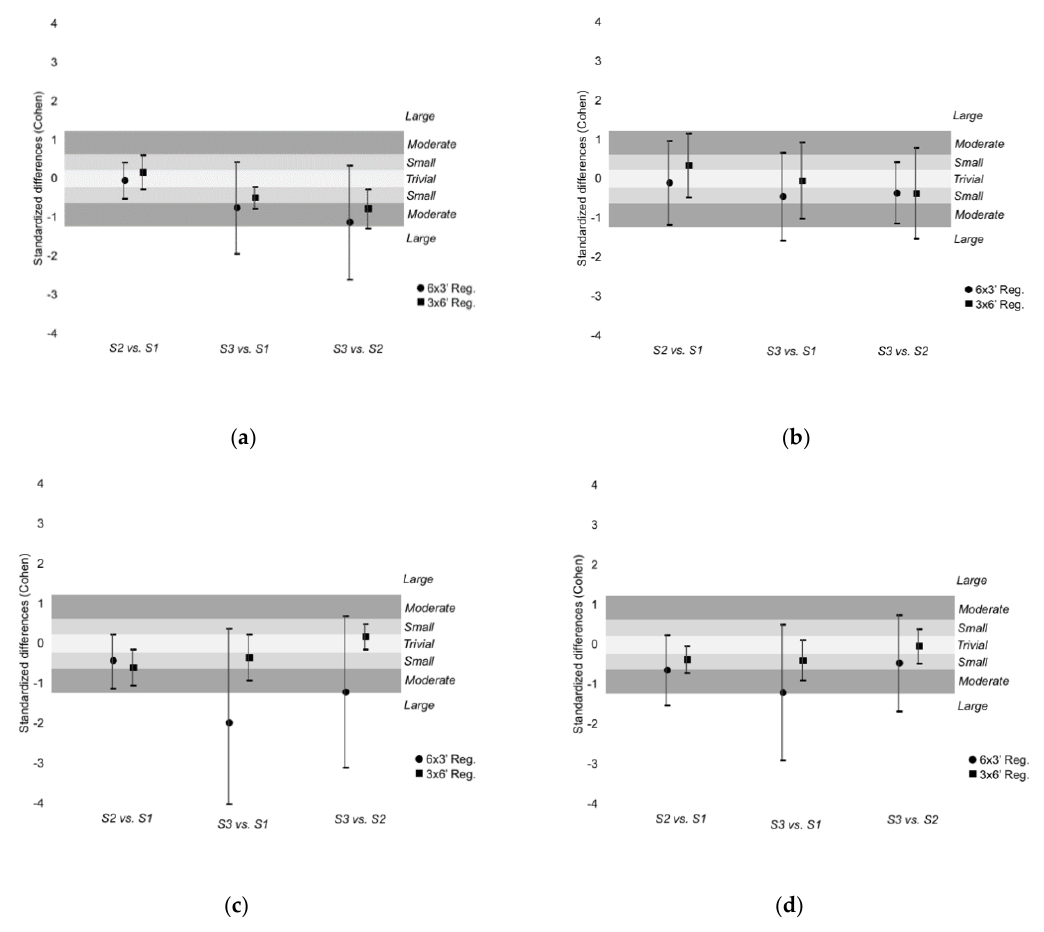
Figure 2. Standardized difference (Cohen) between sets in ( a ) running distance; ( b ) sprinting distance; ( c ) total accelerations; and ( d ) total decelerations. The six sets of the 6 × 3’ regimen were grouped in three sets (S1: mean of set 1 and 2; S2: mean of set 3 and 4; S3: mean of set 5 and 6) to a better visualization and analysis. Standardized value direction depends on the relationship A-B.